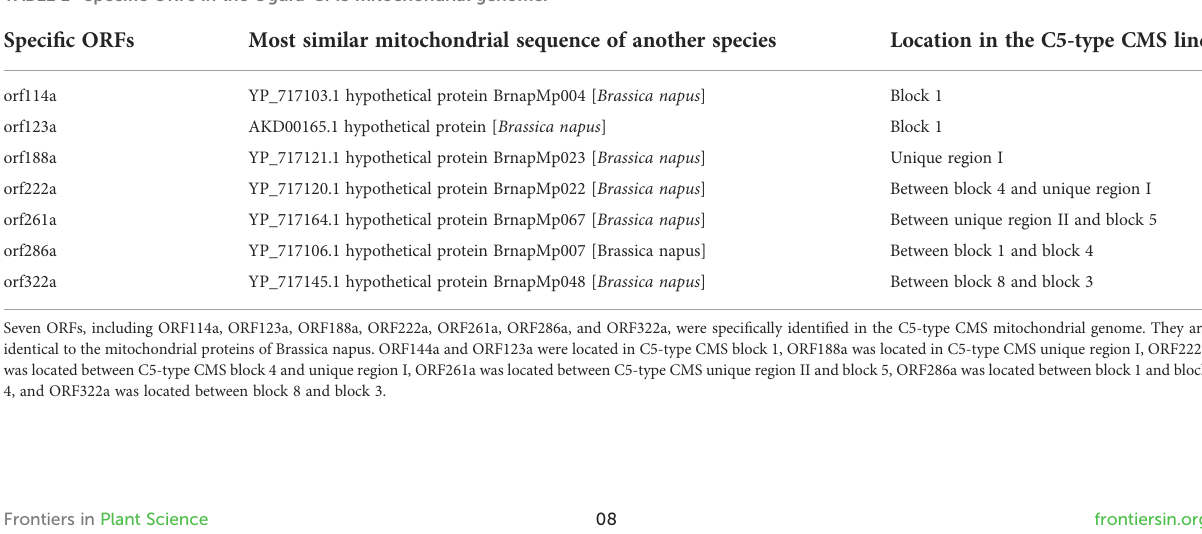
TABLE 1 Speci fi c ORFs in the Ogura-CMS mitochondrial